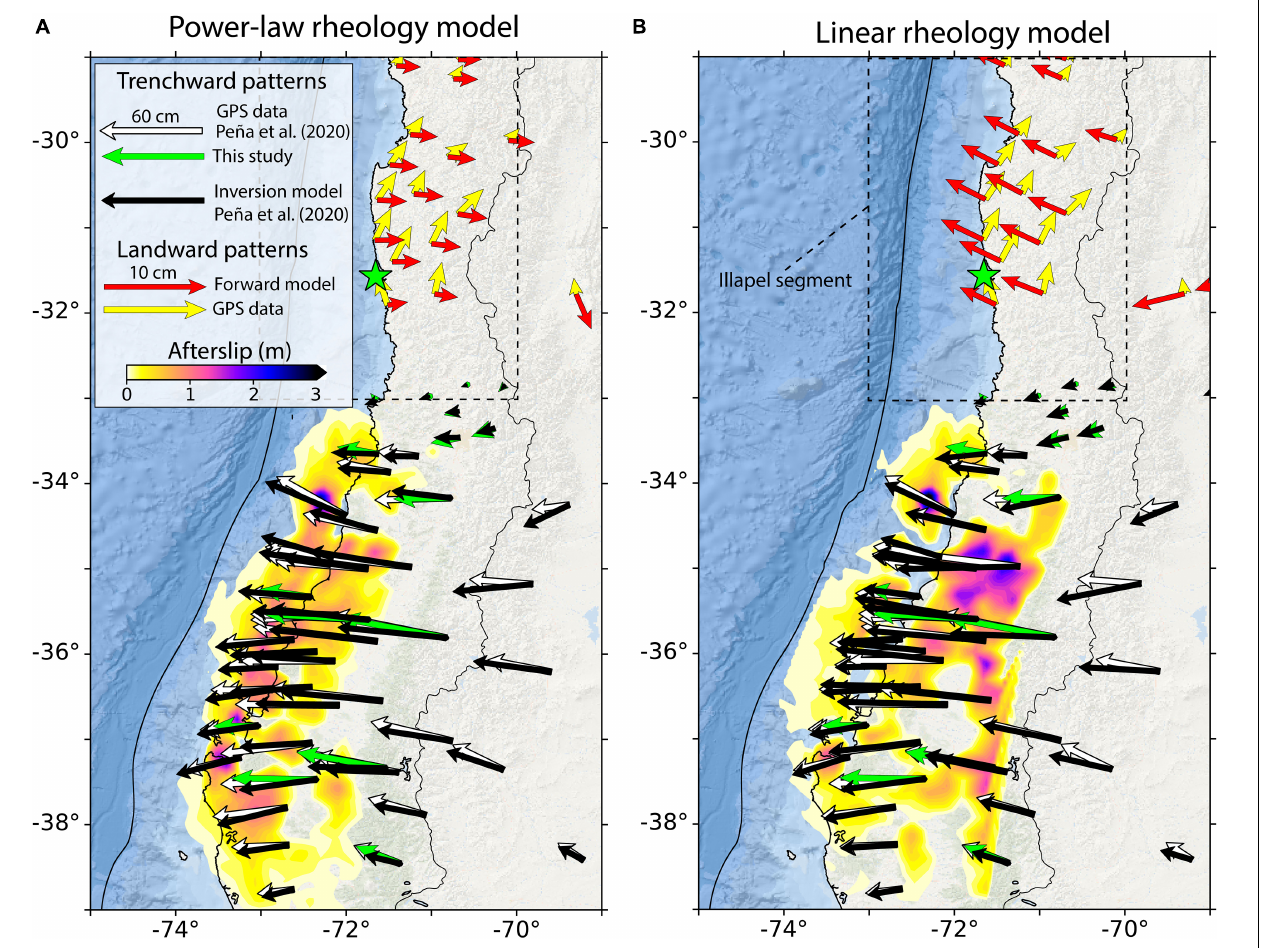
FIGURE 2 | Horizontal cumulative displacements from the GPS data versus the modeled ones, and afterslip inversion on the fault interface (projected on surface) from the simulation considering power-law (A) and linear (B) rheology. The Illapel segment is enclosed by the black-dashed rectangle. The GPS observations used in the study of Peña et al. (2020) cover 6 years from the February 27, 2010 (white arrows). In this study, we investigate the period between the 2010 Maule (February 27, 2010) and the 2015 Illapel (September 16, 2015), which represents 5.5 years. Therefore, the resulting modeled surface displacements displayed in the Illapel segments account for this period, although the differences considering 6 years are negligible. Thus, green (trenchward) and yellow arrows (landward) represent the horizontal cumulative 5.5-years surface displacements from the GPS data used in this study, while the red arrows the ones from the model in the same